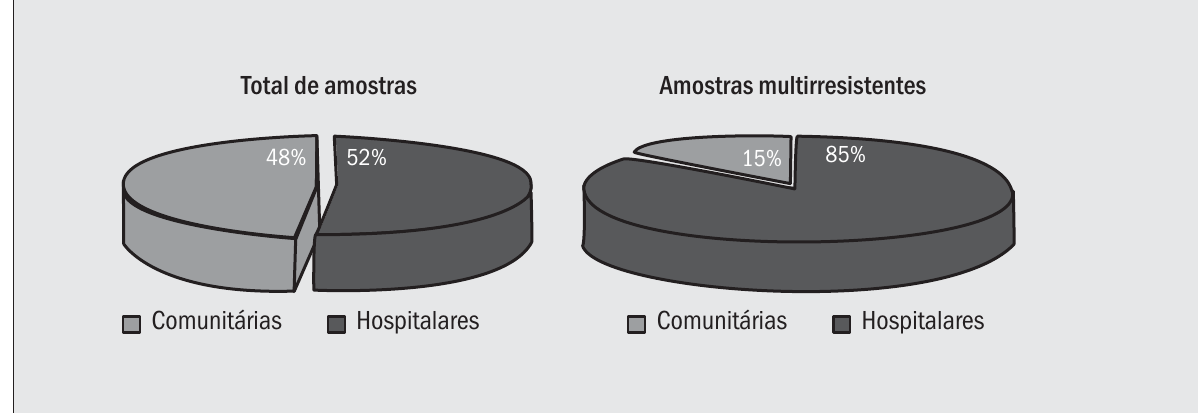
Figura 5 – Origem das 198 amostras de P. aeruginosa